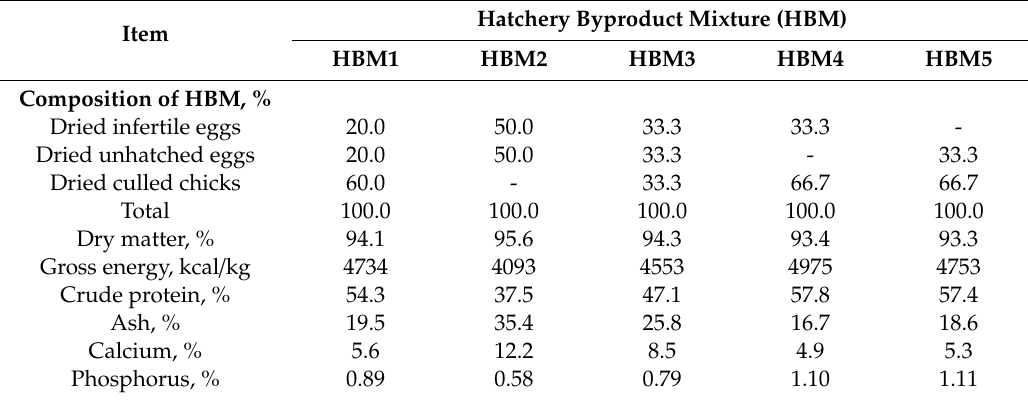
Table 1. Analyzed composition of hatchery byproduct mixtures, as-is